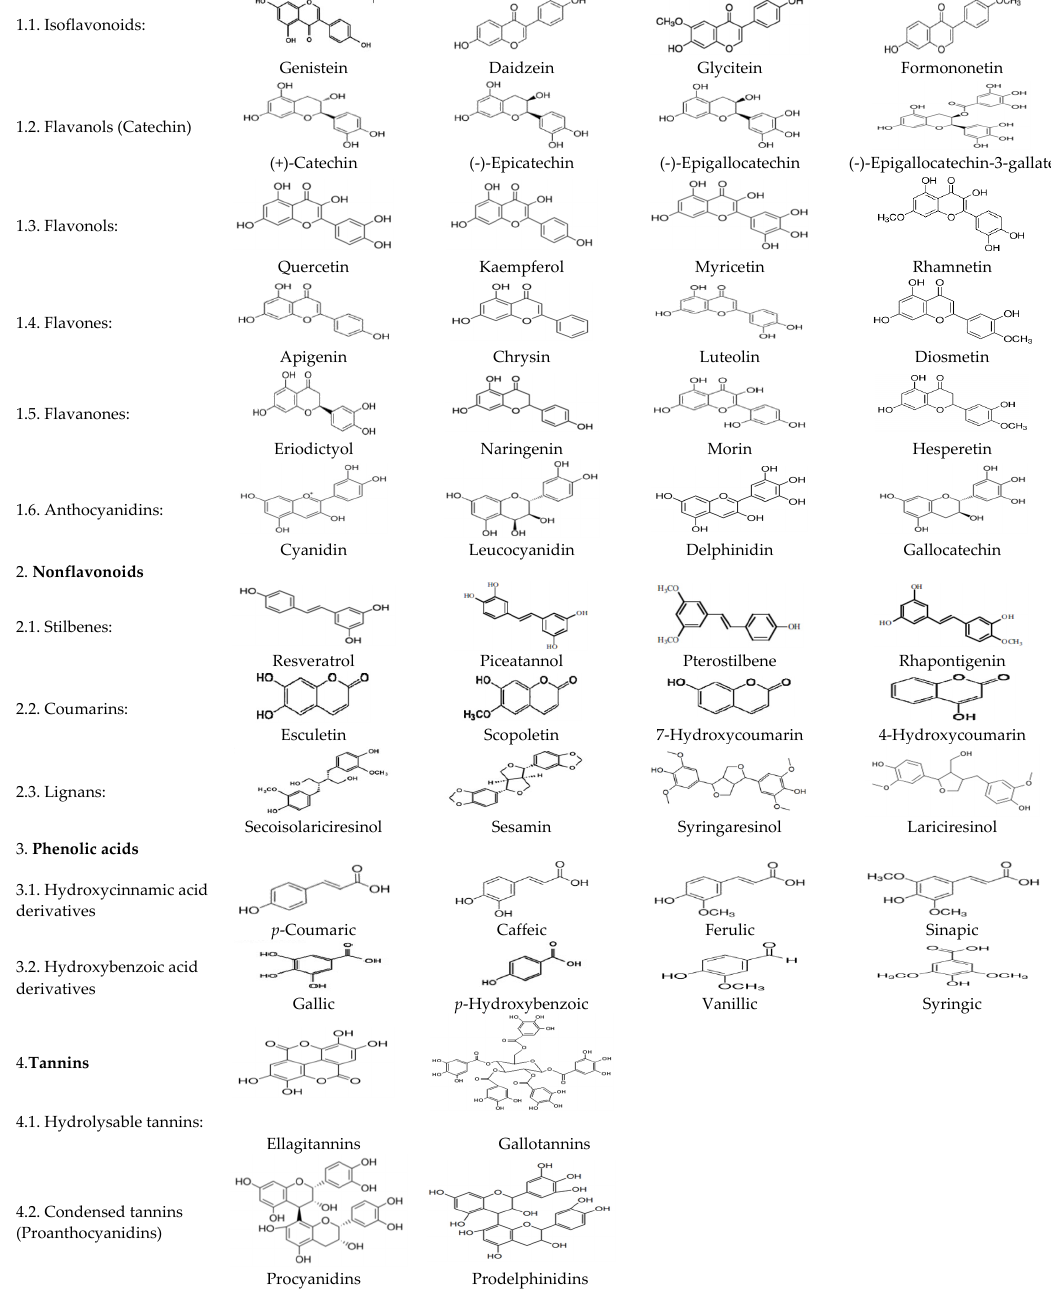
Figure 1. Classes and examples of chemical structures of different plant polyphenols.